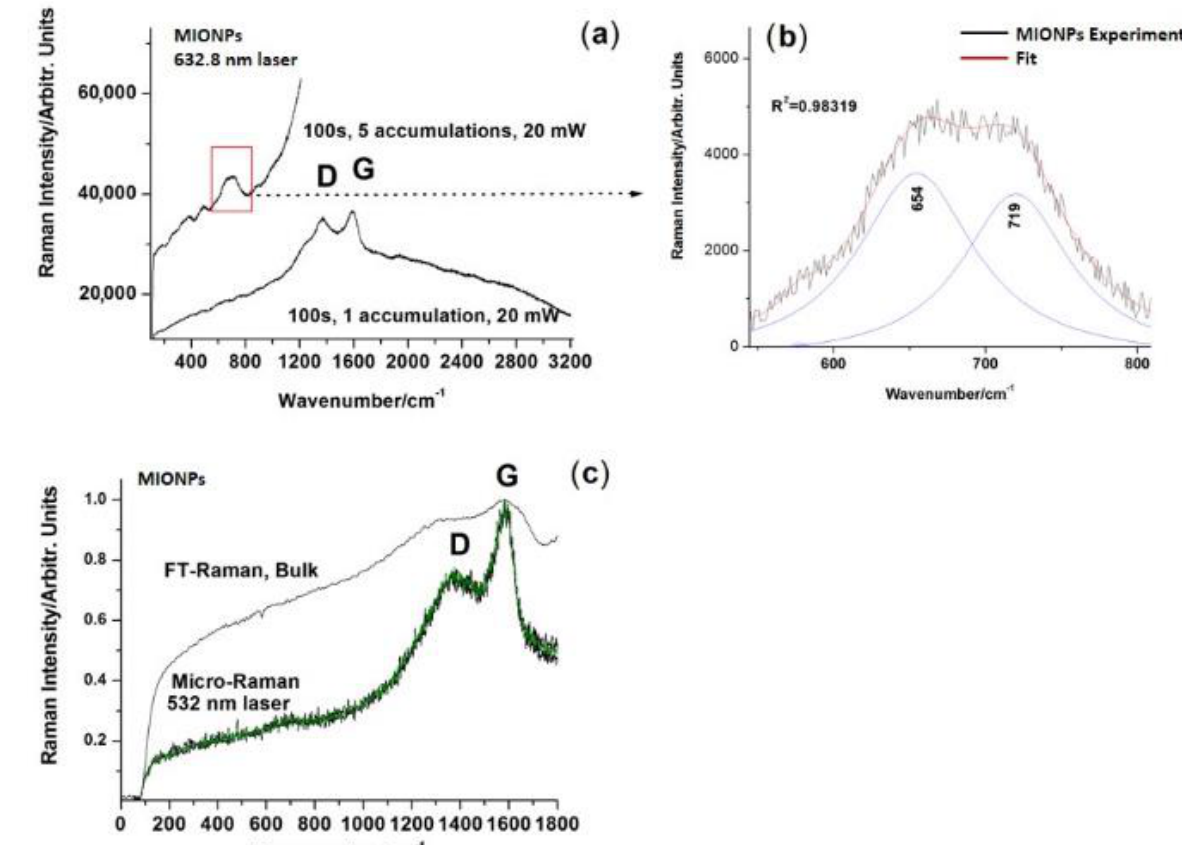
Figure 4. Typical Raman signals collected from the MIONPs in different conditions with different excitation laser lines: ( a ) under 632.8 nm excitation, ( b ) zoom-in of the 550 – 800 cm −1 region showing the deconvolution of the spinel phase marker band, revealing modes of magnetite at 654 and maghemite at 719 cm −1 , ( c ) FT-Raman under 1064 nm and micro-Raman under 532 nm excitation.